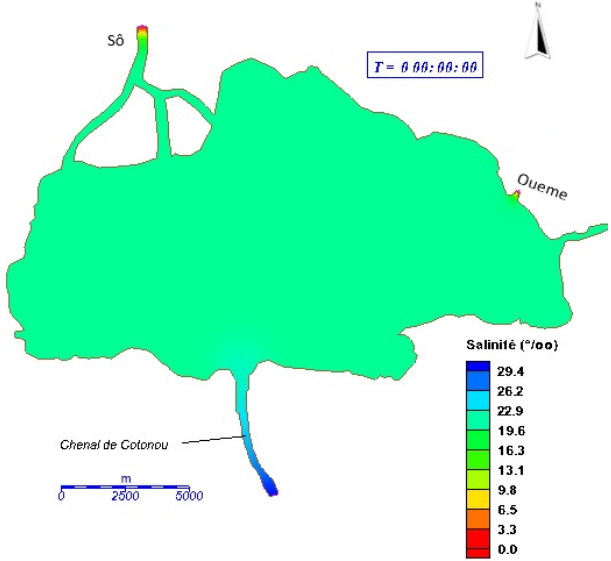
Figure 3. Spatio-temporal variation of salinity-fresh water during the low-flow period after 4h of simulation.